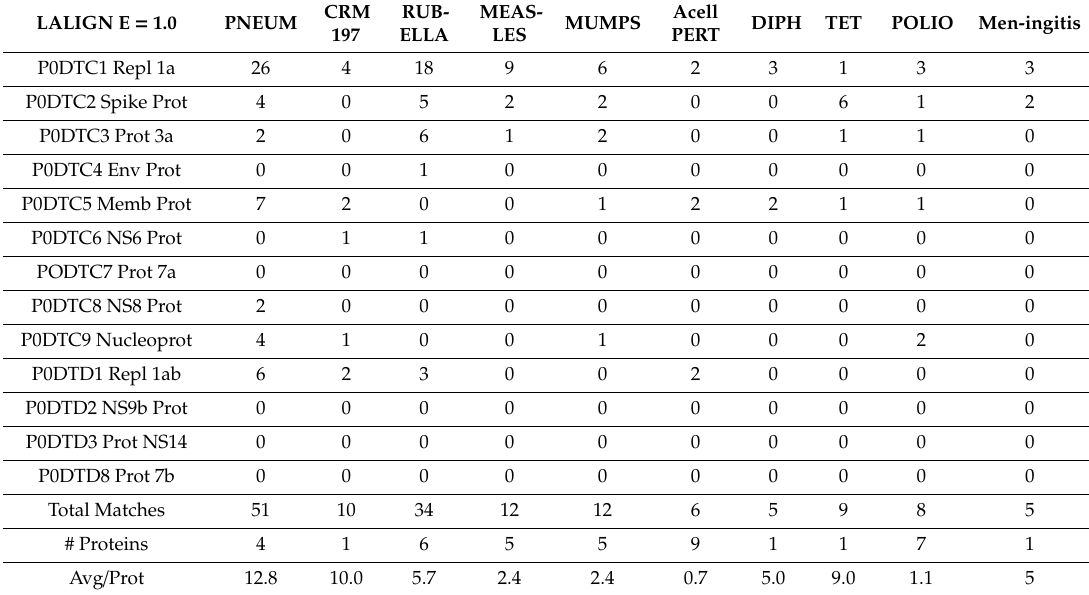
Table 3. Summary of LALIGN searches set to E = 1.0 comparing SARS-CoV-2 proteins (left-hand column) with vaccine proteins (see Table 1 for list of individual proteins). Note that the BLAST searches on Whole PERT and BCG were set to E = 10 because of the much larger size of the entire genome as compared with the average of 17 proteins searched for in the other vaccines. PNEUM = pneumococcal; CRM197 = Cross-Reactive Material 197; Acell PERT = acellular pertussis vaccine; DIPH = diphtheria vaccine; TET = tetanus vaccine; Whole PERT = whole cell pertussis vaccine; BCG = Bacillus Calmette–Guerin, here represented by M. tuberculosis. Avg / Pro = average number of matches per